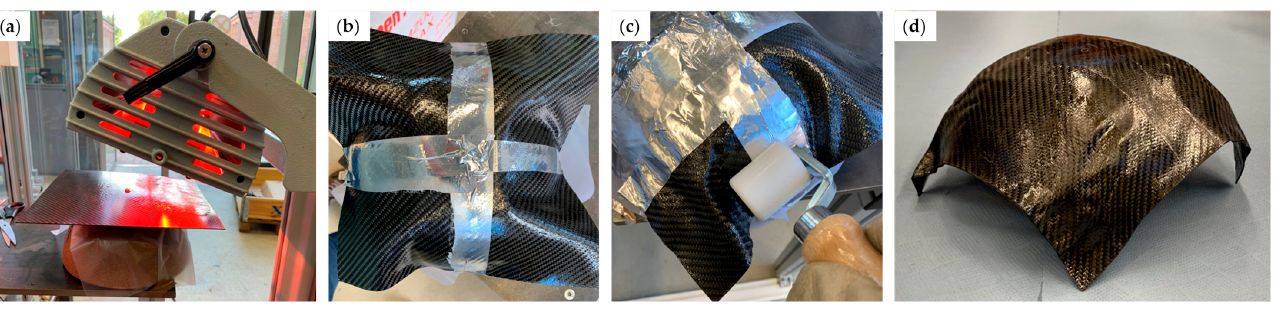
Figure 20. ( a ) Organo sheet centrally fixed to a hemispherical mold and heated by an infrared heater; ( b ) The first four formed paths covered with aluminum adhesive tape for shielding from subsequent heating; ( c ) Forming with a handheld PTFE roller; ( d ) Resulting formed hemisphere.